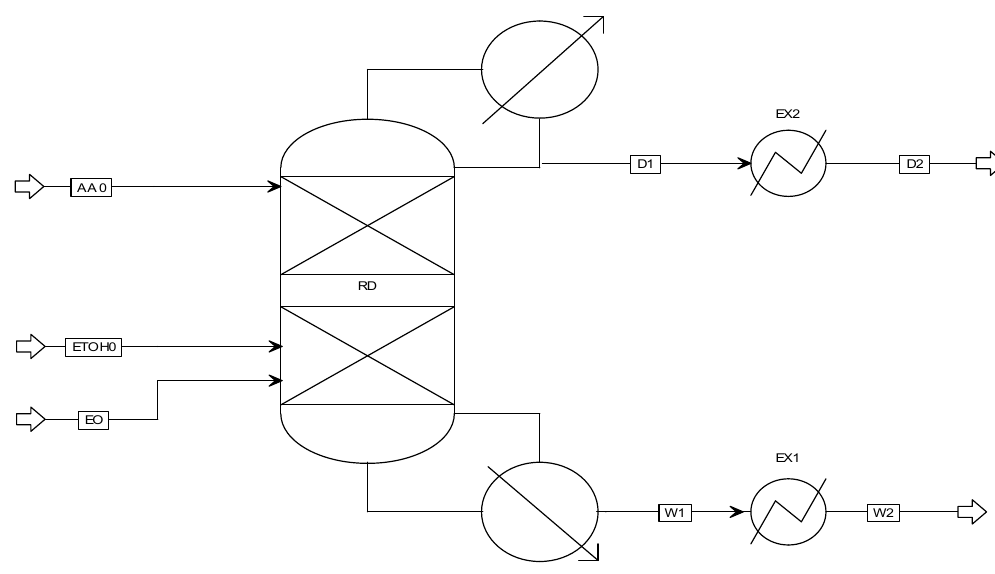
Figure 4. Ethyl acetate production via reactive distillation column with an auxiliary reaction.